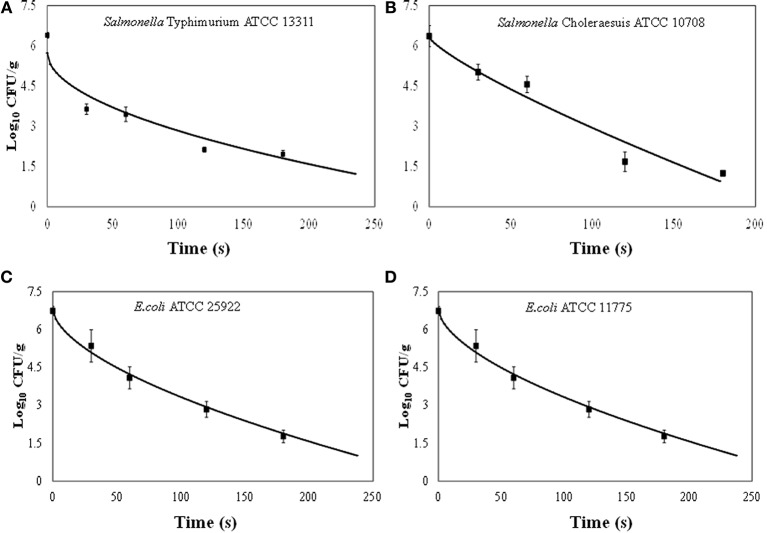
Effect of treatment time on the inactivation of Salmonella Typhimurium, ATCC 13311 (A), Salmonella Choleraesuis, ATCC 10708 (B), Escherichia coli ATCC 25922 (C), Escherichia coli ATCC 11775 (D) on apples by the atmospheric cold plasma treatment using air as the plasma-forming gas. Error bars denote standard deviations.